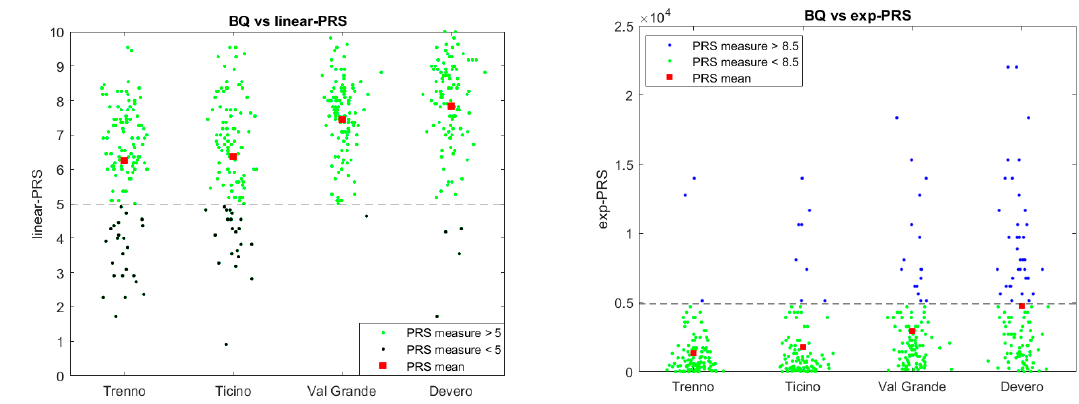
Figure 5. The figure on the left shows that the PRS discriminates between restorative and non-restorative settings (median cut-off score: 5). On the contrary, the scatter plot on the right points out that PRS score above 8.5, in exponential scale, is a good feature for setting